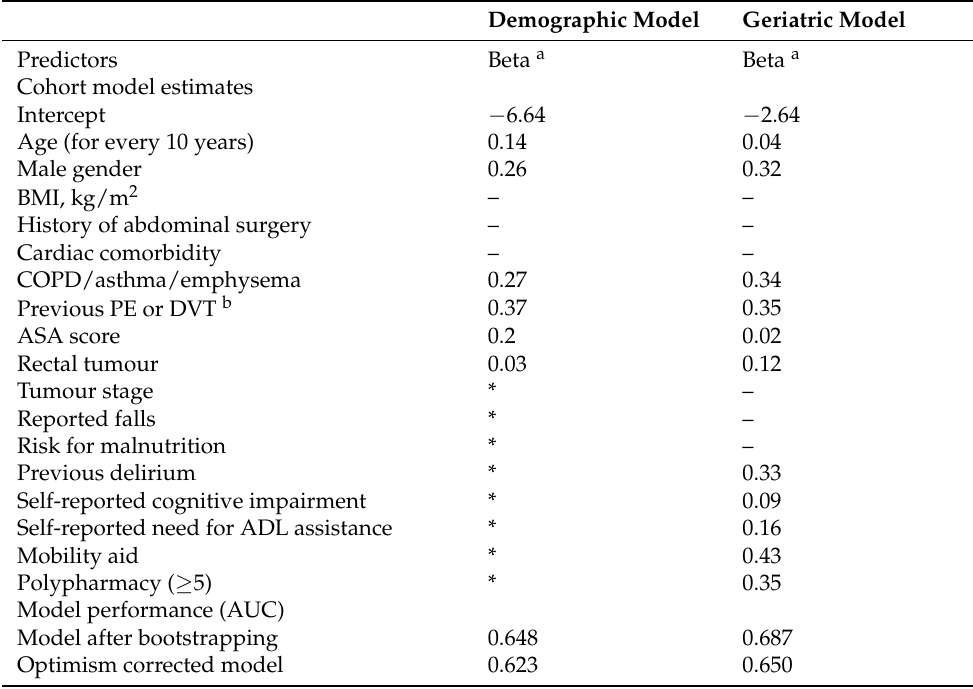
Table 2. Model development and multivariable regression coefficients after shrinkage.